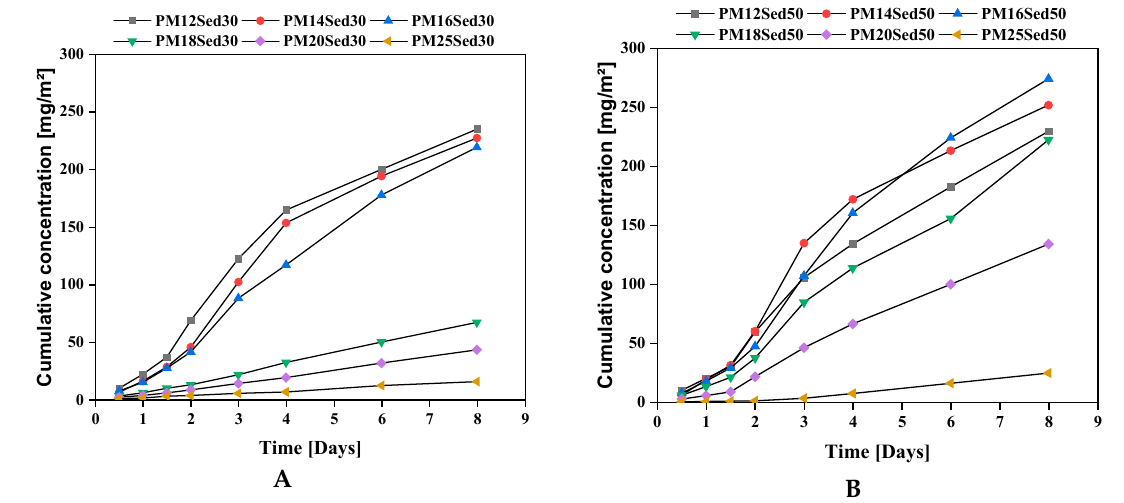
Figure 7. Evolution of cumulative concentration of magnesium in leachates from monolithic polymer mortars containing 30% ( A ) and 50% ( B ) of sediments in their matrices. Redox potential variations were measured in leachates for all formulations and are shown in Figure 8. The values are positive and in the range between 150 and 330 mV for polymer mortars, including 30 and 50%. It means that the medium is oxidized, and there is no redox buffer in the sediment and sand constituents. It can be noted that no difference is measured between all formulations suggesting that this parameter is strongly inde- pendent of the chemical composition of polymer mortars. A B Figure 8. Evolution of redox potential in the leachates from monolithic polymer mortars containing 30% ( A ) and 50% ( B ) of sediments in their matrices.